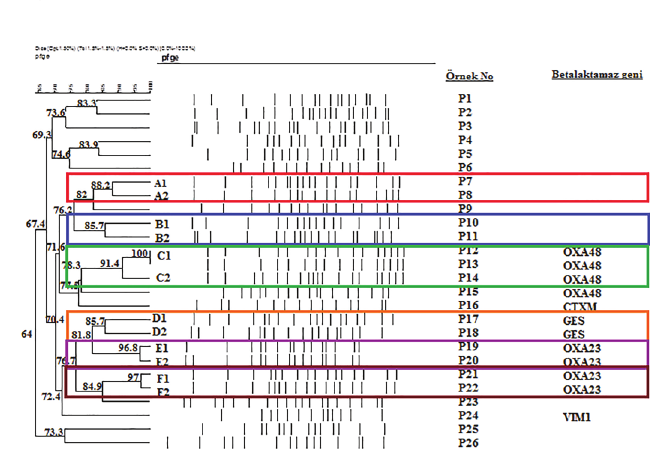
cluster at a rate of 94.1% and the B1-B2 members that formed the B cluster were closely related to each other at the rate of 92.1%. We determined that the OXA-48-CTXM-9 genes in the A1 cluster, the OXA-24-CTXM-9 genes in the A2 cluster and the OXA-48 gene in the B cluster (Figure Figure 4 - Phylogenetic relationships of K. pneumoniae